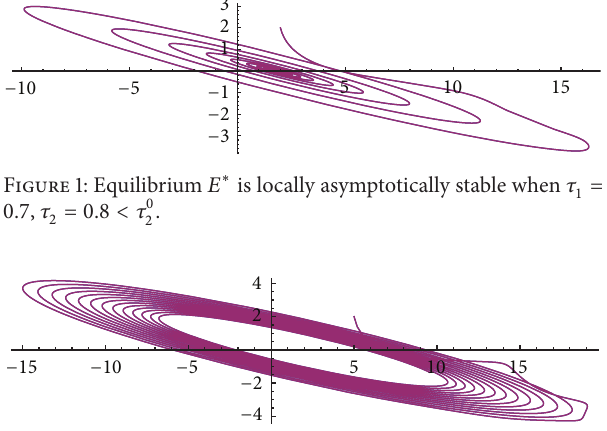
Figure 2: Equilibrium 𝐸 ∗ is unstable when 𝜏 1 = 0.7 , 𝜏 2 = 0.9 > 𝜏 0 2